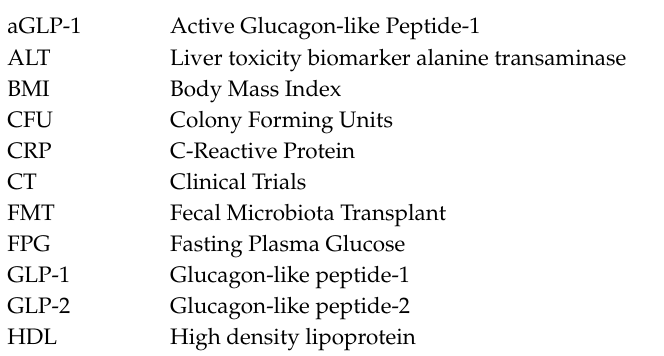
Figure S1: Overall searching with the key words “Probiotics and Obesity”; Table S1: Key words and search terms; Table S2: Summary of the probiotic strain’s e ff ects in obesity and related metabolic disorders from selected animal model data studies; Table S3: Overall analysis of 10 reviews for retrieving data on Probiotic strains, doses and administration pattern in obesity-related clinical studies (CT / animal